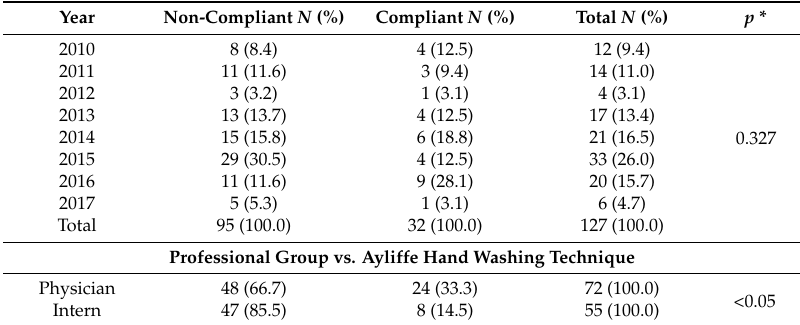
Table 7. Summary of observations on compliance with the Ayliffe hand washing technique made between 2010 and 2017 with division into professional